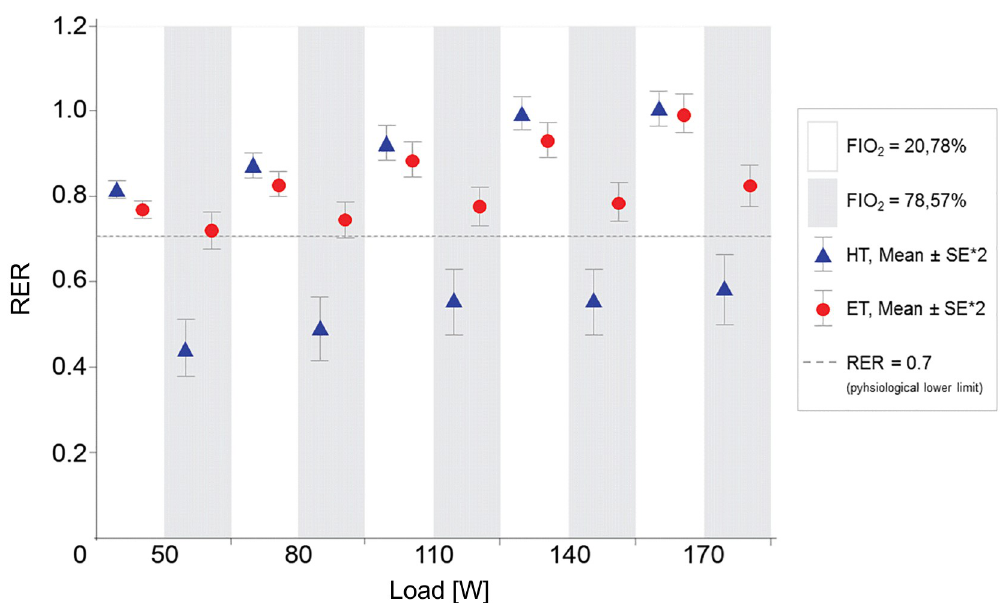
Fig 5. RER comparison at FIO 2 = 20.78% versus FIO 2 = 78.57% between HT and ET. HT and ET show plausible RER- values at FIO 2 = 20.78%. At FIO 2 = 78.57% there are incomprehensible values of HT (RER < 0.70), while the ET remains constant. RER < 0.70: An RER of 0.70 corresponds to pure fat burning without accompanying carbohydrate metabolism; a lower ratio of carbon dioxide release to oxygen uptake (the RER) is physiologically not possible. Abbreviations: HT Haldane Transformation, ET Eschenbacher Transformation.